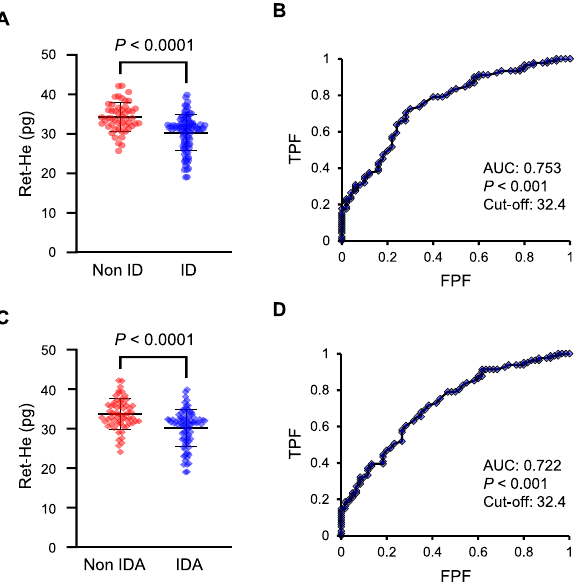
Figure 3. Ret-He levels in HF patients with and without iron deficiency. ( A ) Ret-He levels in HF patients with ( n = 92) and without ID ( n = 50). ( B ) ROC curve of Ret-He to screen for ID. ( C ) Ret-He levels in HF patients with ( n = 82) and without ( n = 60) IDA. ( D ) ROC curve of Ret-He to screen for IDA. ID iron deficiency, IDA iron deficiency anemia, AUC area under the curve, TPF true positive fraction, FPF false positive fraction.